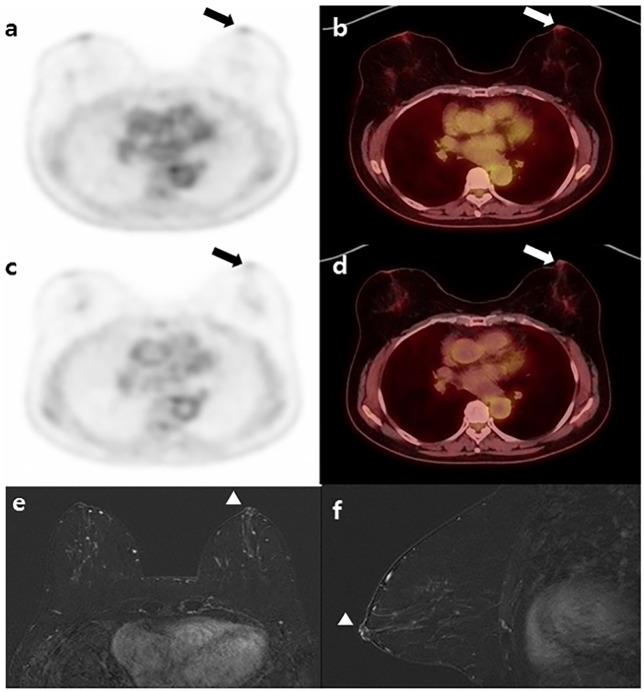
A 48-year-old patient with IDC in the left breast: (a, b) Early phase 18F-FDG PET and fusion PET/CT; (c,d) Delayed phase PET and fusion PET/CT show no significant FDG uptake in the NAC of the left breast (arrow), NAC-SUVRearly = 0.95; NAC-SUVRdelay = 0.92; (e) Contrast-enhanced MRI with axial view and (f) MRI with sagittal view; MRI reveals no definite evidence of abnormal contrast enhancement of the NAC in the left breast (arrowhead).This patient underwent breast conserving surgery, and pathologic NAC non-involvement was confirmed.